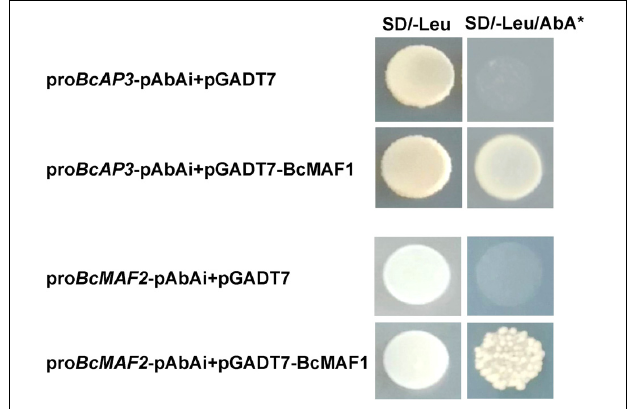
FIGURE 5 | Binding activities of BcMAF1 protein with the promoters of BcMAF2 and BcAP3 detected by yeast one-hybrid assays. The yeast cells were grown on SD/-Leu medium plate supplemented with or without 300 ng/mL AbA.